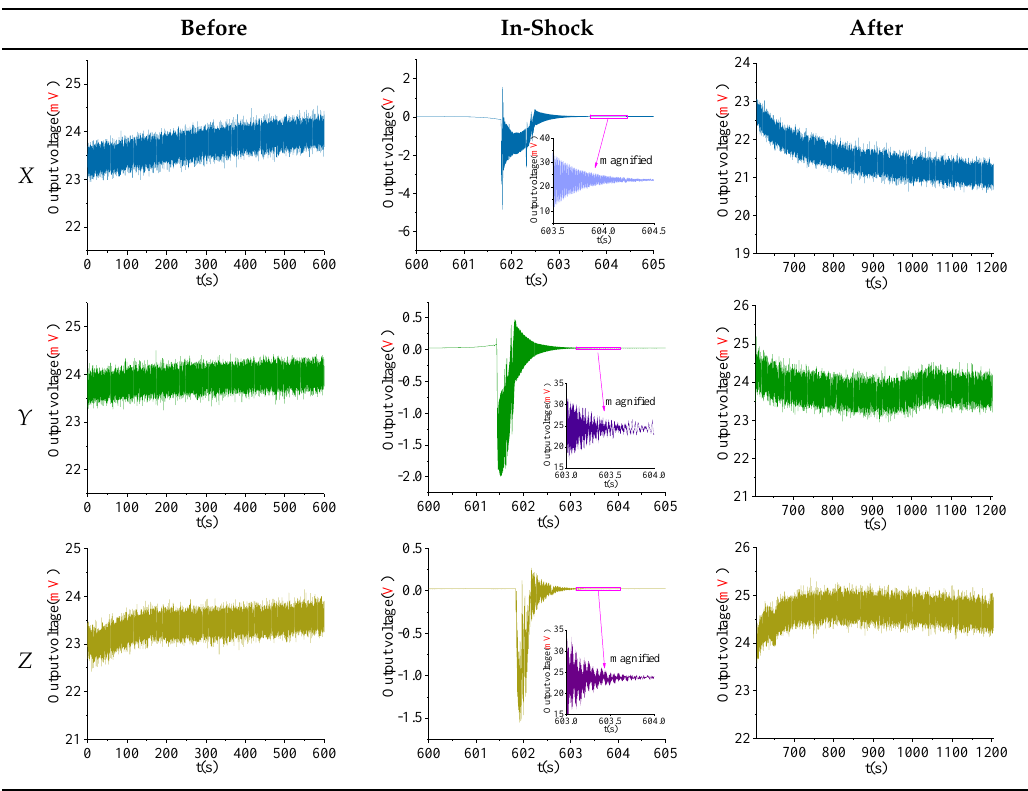
Table 5. The shock experiment